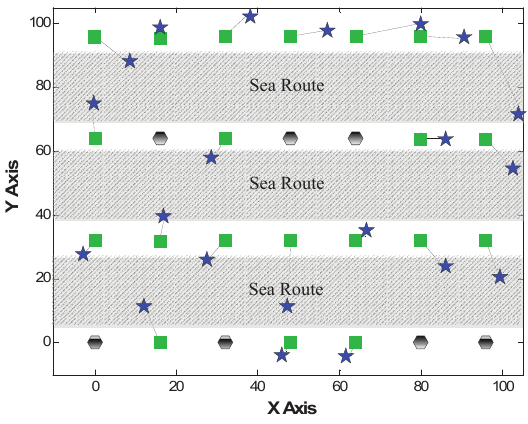
Figure 9. Localization results of